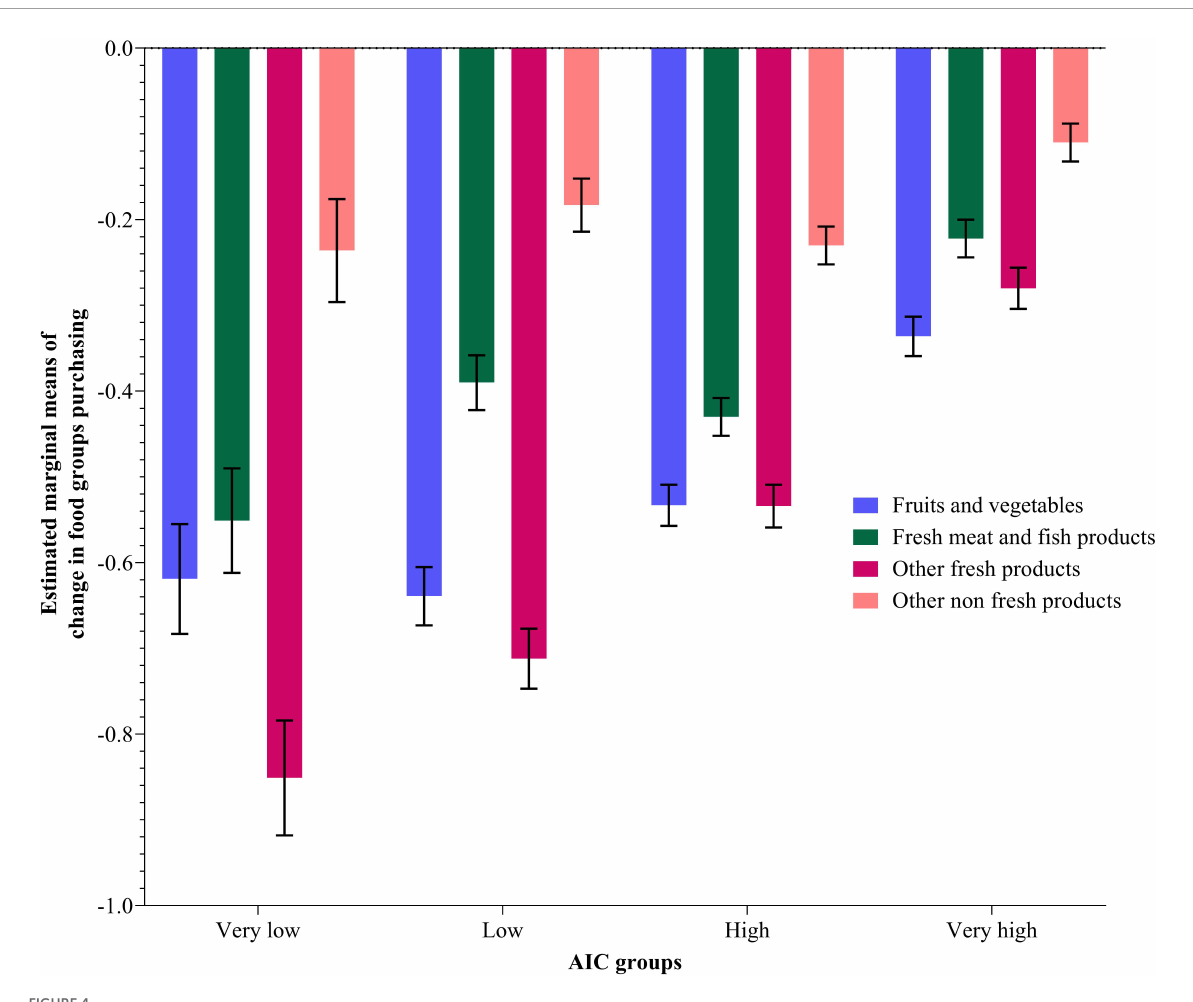
FIGURE4 Estimated marginal means using MANOVA procedure for different food types purchasing change (During—Before COVID-19) per AIC groups. Data weighted by countries (see also Supplementary Table 5